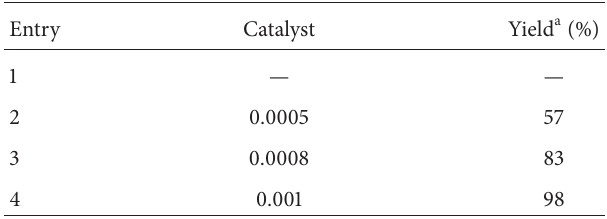
Table 3: Optimization amount of Kaolin/Ag nanocomposite cata- lyst for the synthesis of 4a .